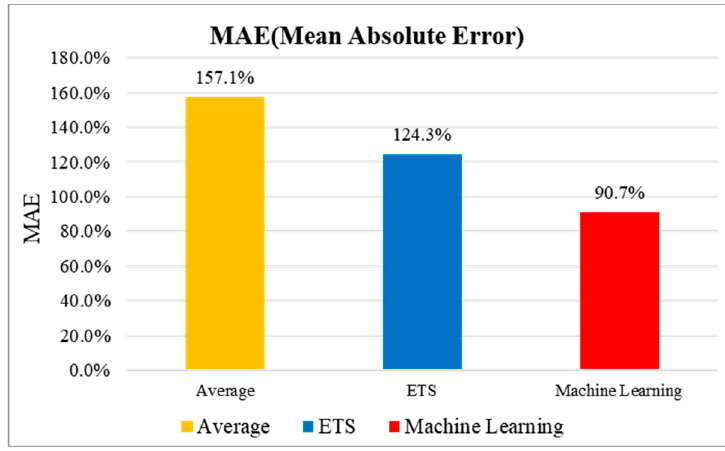
Figure 8. Data Forecasting and Reasoning by ML.